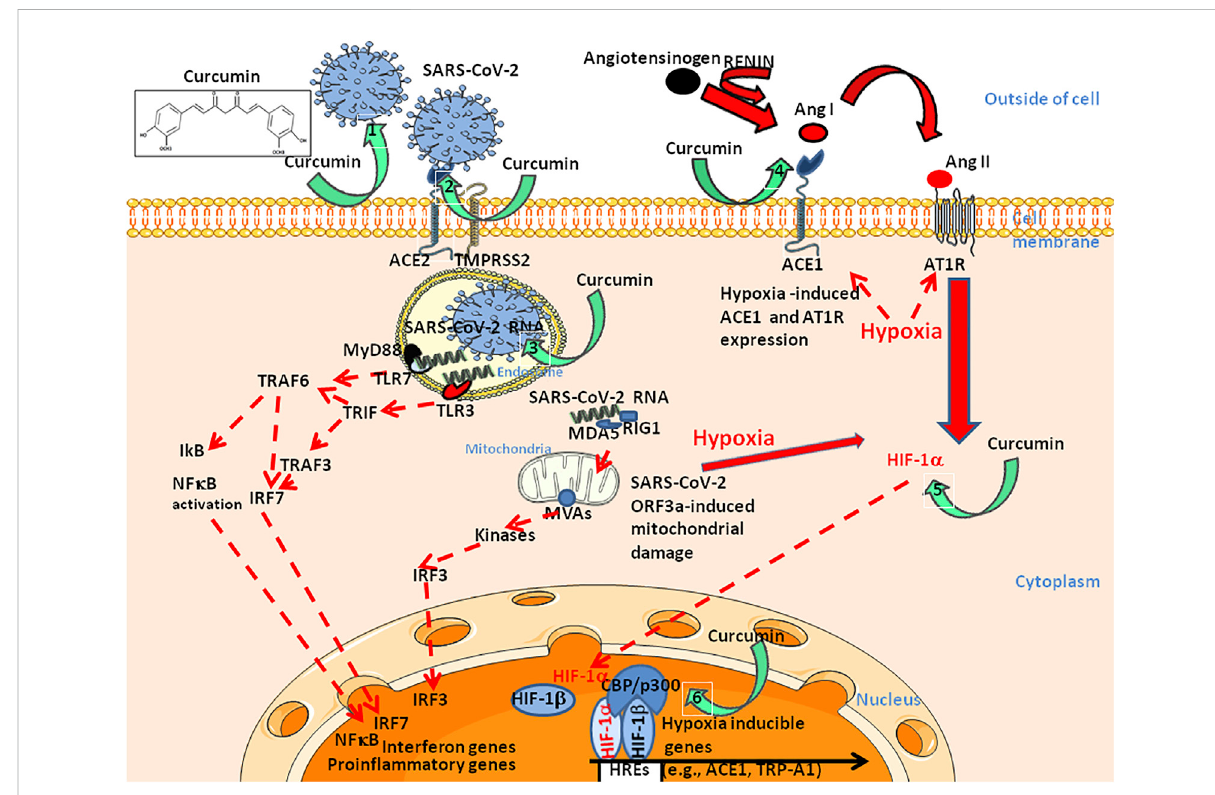
Schematic diagram illustrating six of the potential curcumin targets during SARS-CoV-2 infection of susceptible cells with a speci fi c focus on: Left: viral entry pathway (right panel, targets 1 – 3) and, Right: Ang II induced hypoxia pathway (left panel, targets 4 – 6). Regarding the viral entry pathway, curcumin prevents the binding of the SARS-CoV-2 S protein to the ACE2 receptor by binding to both proteins (1,2). In addition, curcumin prevents endosomal acidi fi cation required for the initiation of viral replication (3). Regarding the Ang II pathway, curcumin inhibit ACE1 (4), thus preventing the accumulation of Ang II. Moreover, curcumin prevents hypoxia-induced HIF1- α upregulation (5) and p300 acetyl transferase activity withintheHIF1- α / β /CBP-p300complex(6).Upperleft,chemicalstructureofcurcumin(diferuloylmethane).EffectsofcurcuminonTrpionchannels suchas TrpA1and TrpV1, have also been reported (notshown). ACE:Angiotensin converting enzyme; Ang:Angiotensin; AT1R: Ang II typeI receptor; CBP/p300: Histone acetyltransferases CREB Binding Protein (CBP)/p300; IRF: Interferon regulatory factor; MDA: Melanoma